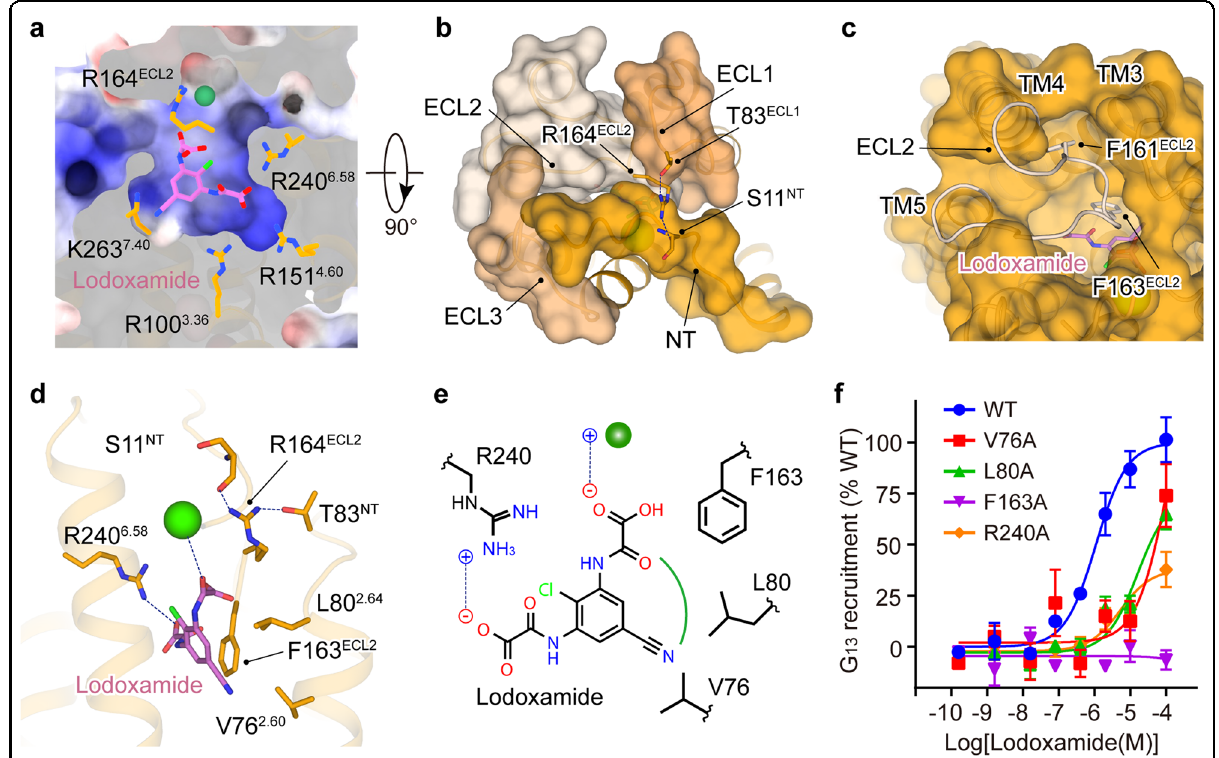
Fig. 3 Lodoxamide recognition by GPR35. a Cross-section of the lodoxamide-binding pocket in GPR35. The pocket is colored by electrostatic surface potential, with the positive potential colored in blue. b , c The extracellular view of GPR35. The N-terminus (NT), all ECLs (ECL1, ECL2, and ECL3), which cover the ligand-binding pocket, are shown in a surface presentation ( b ). The polar interactions between these extracellular receptor components are indicated by blue dashed lines. ECL2 stretches into the ligand-binding pocket and stuffs the space embraced by lodoxamide and the extracellular portion of TM3, TM4, and TM5 ( c ). d Detailed interactions that contribute to lodoxamide binding in GPR35. The polar interactions are depicted by blue dashed lines. e 2D presentation of the interactions between lodoxamide and receptor. f Effects of pocket residue mutations on lodoxamide-induced G 13 recruitment by